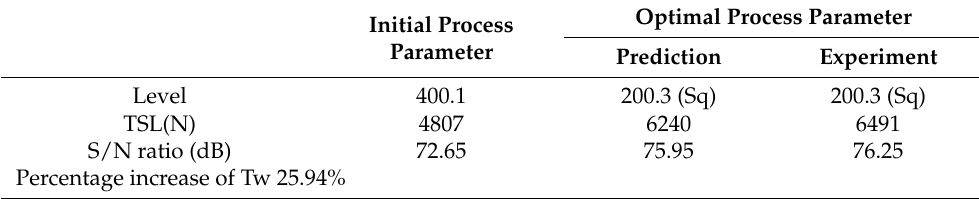
Table 12. Confirmation test results for